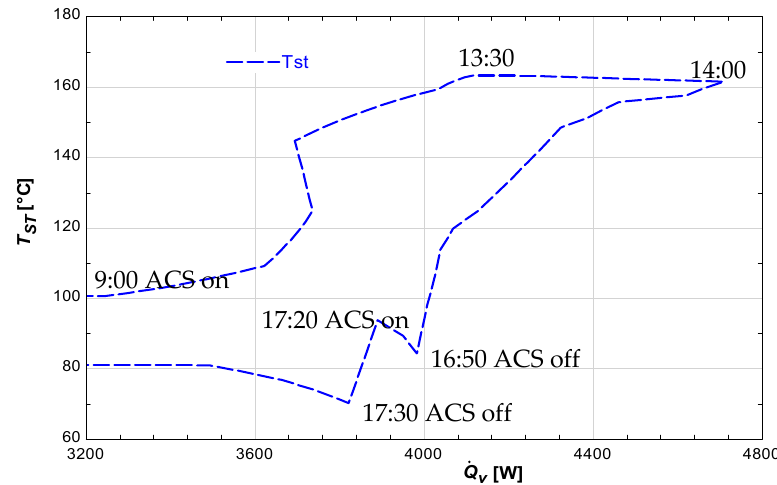
Figure 11. Cooling load influence on the storage tank fluid temperature along the day; case study 9.8 m PTC, 0.16 m 3 water storage tank.